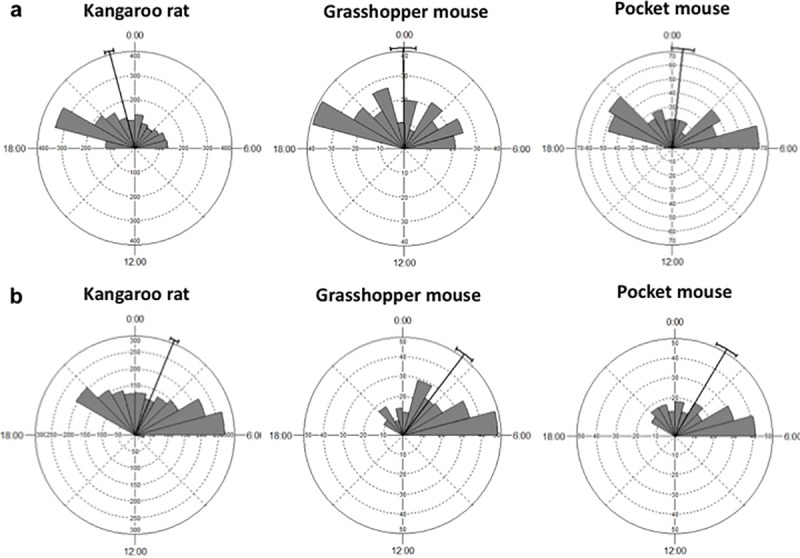
Diel activity patterns of non-competent hosts species.(a) samples from late winter, and (b) samples from spring. Bars indicate the proportion of independent records taken at that time of the day. Tick lines represent the mean vector and its circular standard deviation.